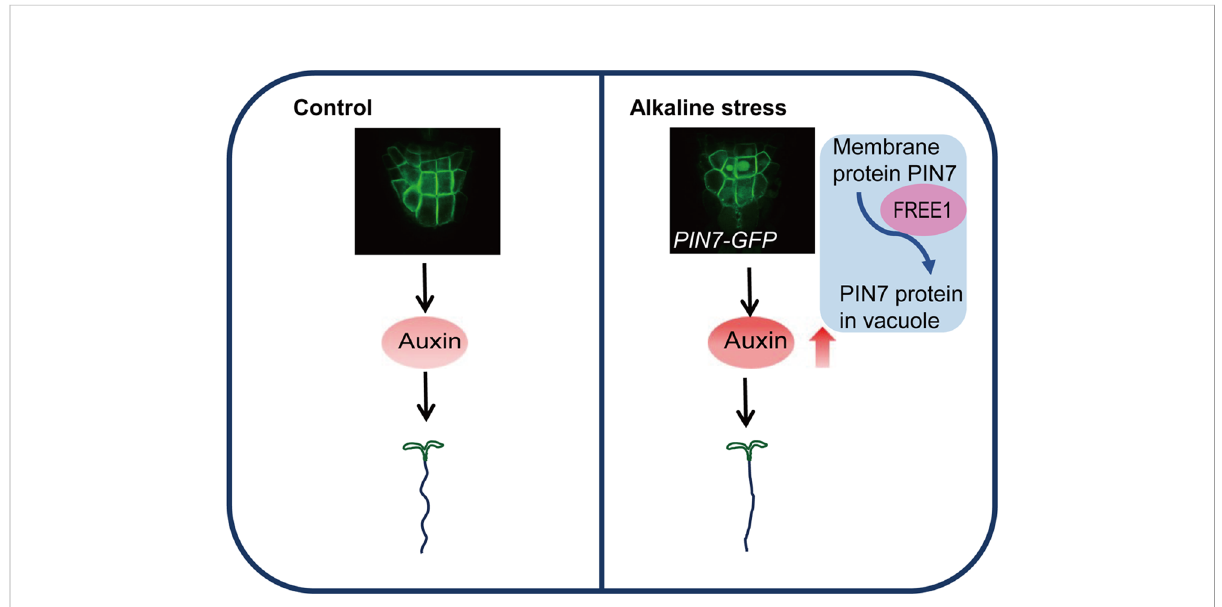
FIGURE 7 Proposed model of PIN7-regulated root morphology under alkaline stress. A simpli fi ed model describes the PIN7-regulated root morphological changes under alkaline stress based on the major conclusions from this work. (1) Under alkaline conditions, auxin accumulation in root columella cells results in reduced root waving pattern. (2) The vacuolar transport of PIN7 is responsible for the increased auxin level and thus normal root response to alkaline stress. (3) The ESCRT component FREE1 is a key factor regulating PIN7 vacuolar transport and proper root morphology under alkaline conditions.